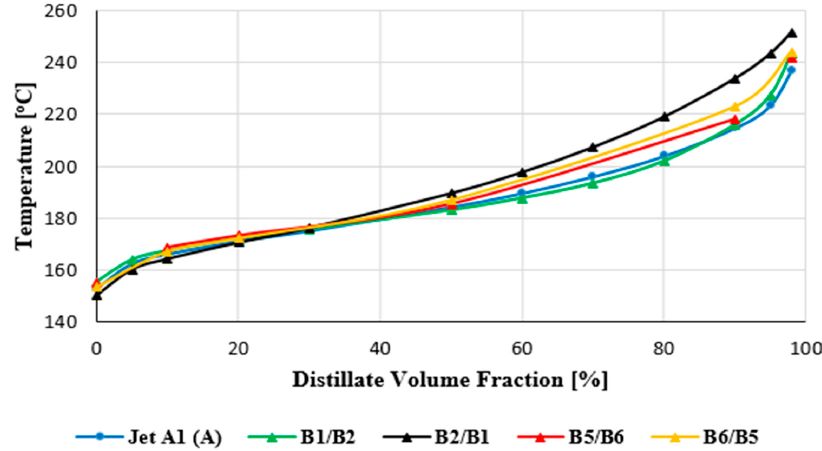
Figure 6. Fractional composition of blends composed using Jet A-1(A).